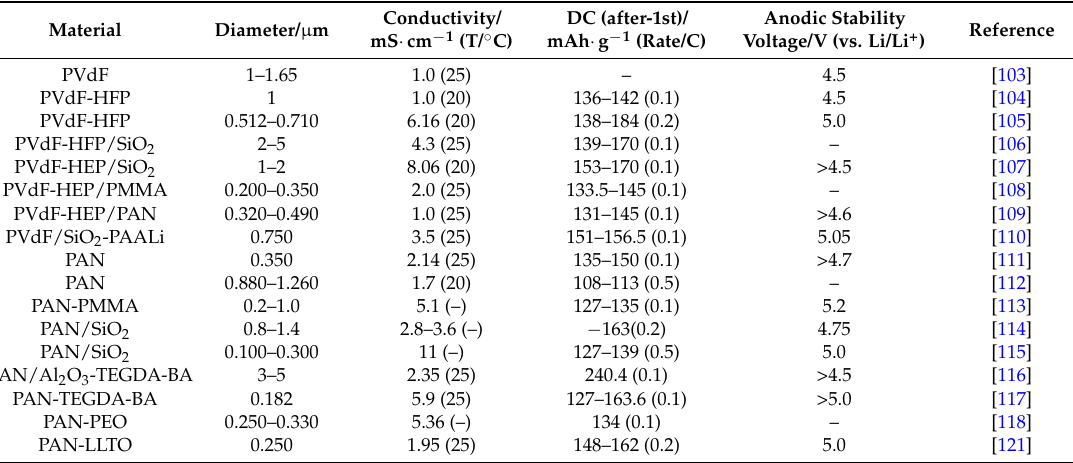
Table 3. Electrospun separators for LIBs and the corresponding electrochemical performance. PVdF: poly(vinylidene fluoride); HFP: hexafluoropropylene; TEGDA-BA: triethylene glycol diacetate-2- propenoic acid butyl ester; PEO: polyethylene oxide; LLTO: lithium lanthanum titanate